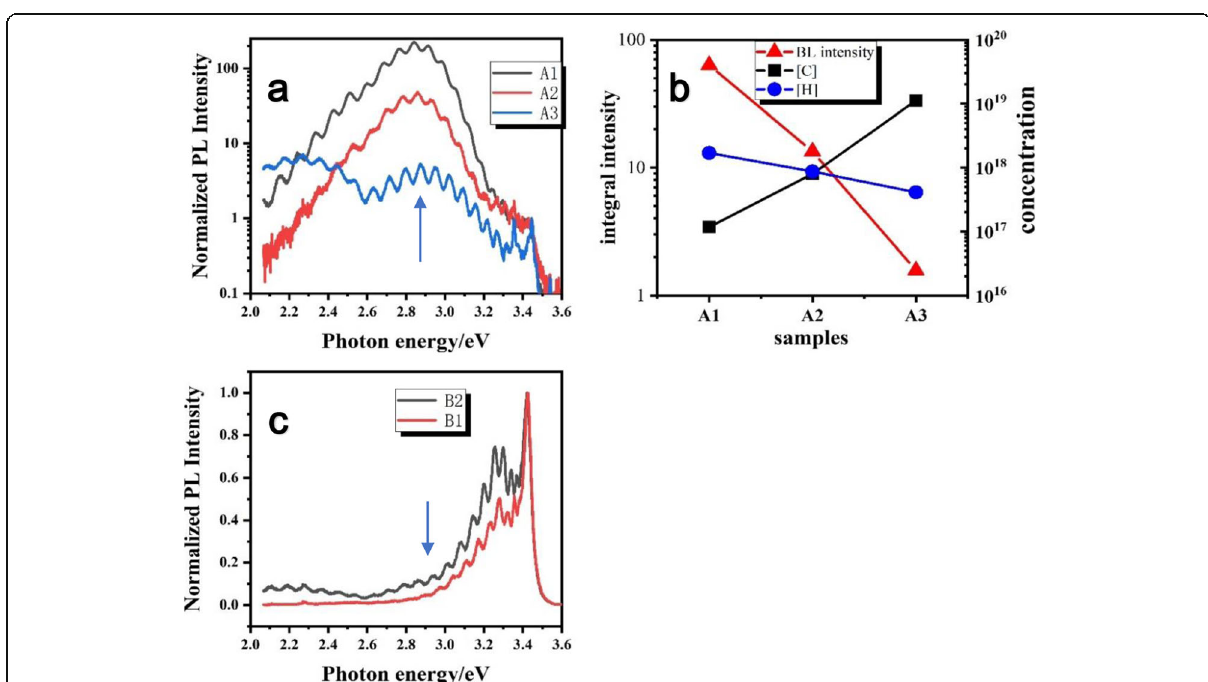
Fig. 2 a The results of normalized PL intensity of samples A1~A3. b The integral PL (solid triangle) intensity and C (solid square) and H (solid circle) concentrations for samples A1~A3. c The results of normalized PL intensity of samples B1and B2